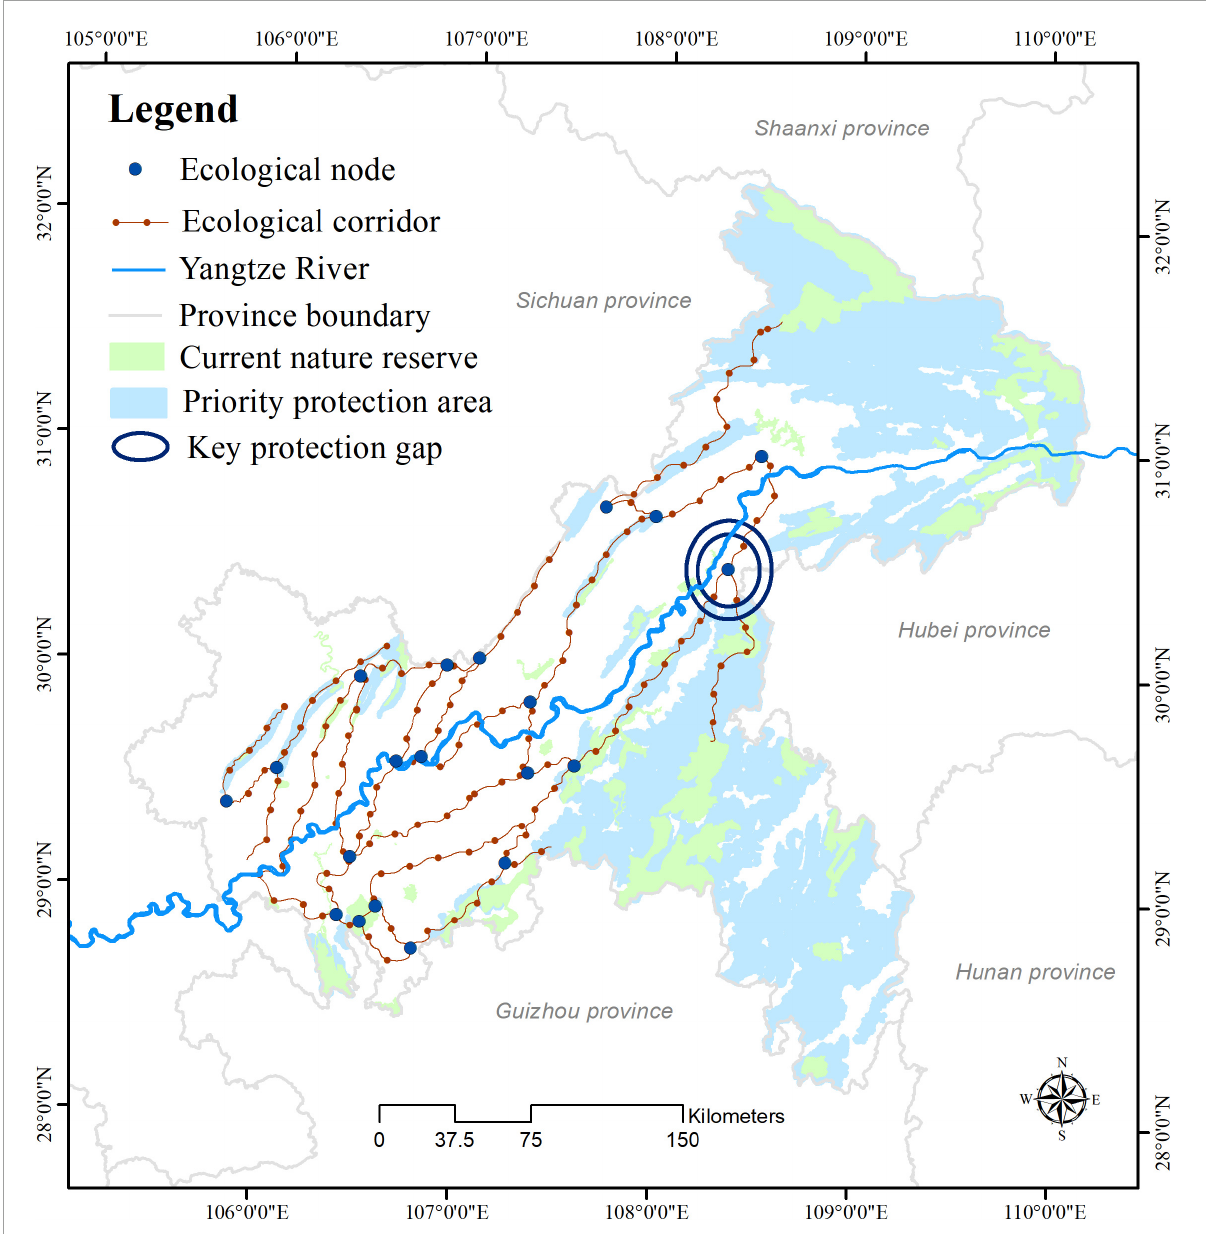
FIGURE6 Spatial distribution of ecological security pattern of Chongqing Municipality. The ecological corridors were simulated by the Circuit Theory model based on the habitat quality and ecological resistance layer of 2020. The priority protection area are the intersection area of the ecological source patches of Chongqing Municipality in 2000, 2010, and 2020. The ecological nodes are the intersection points of more than two ecological